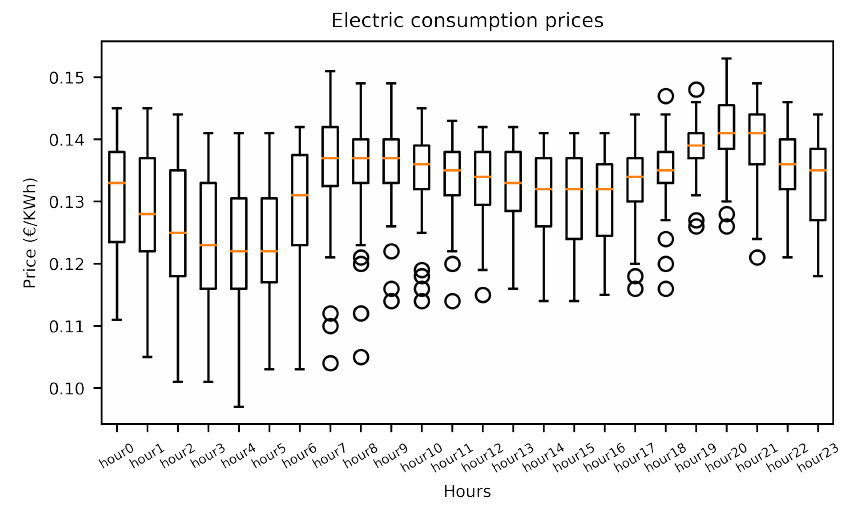
Figure 8. Distribution of the prices